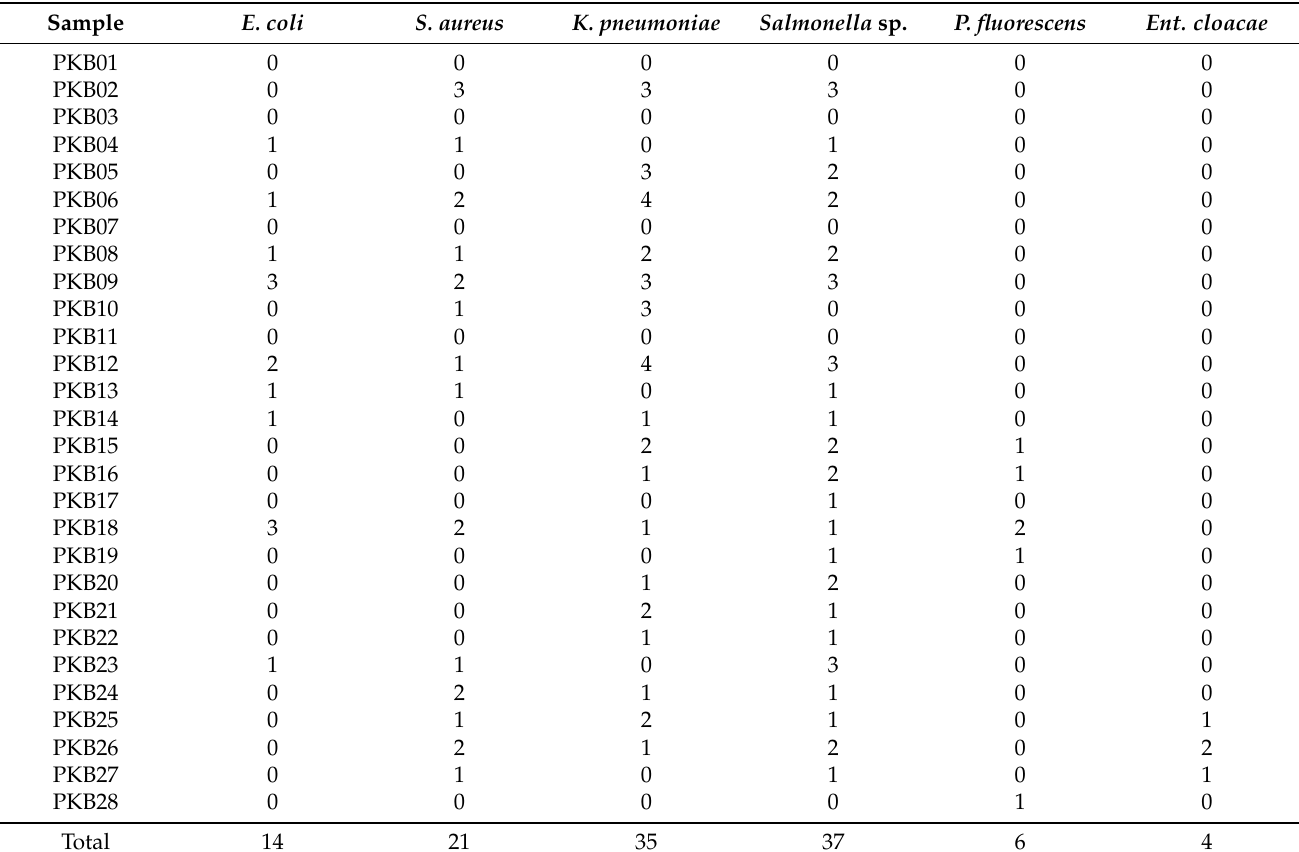
Figure 4. Kriging mapping of inhibition against different pathogens: ( a ) E. coli , ( b ) S.aureus , ( c ) K. pneumoniae , ( d ) Salmonella sp., ( e ) P. fluorescens , and ( f ) Ent. cloacae . Table 2. Inhibition against relative safe pathogens (number of positive